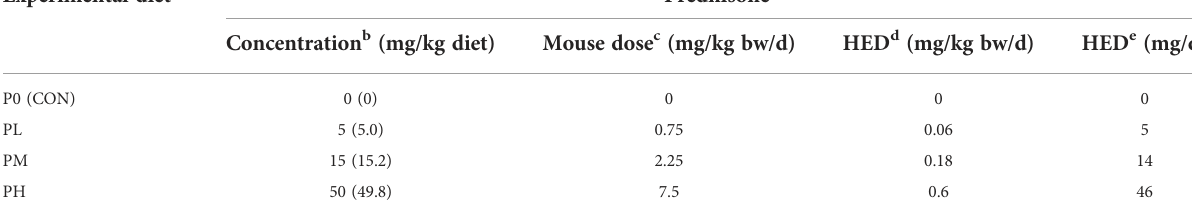
TABLE 1 Relation of prednisone concentrations in experimental diet to mouse and human daily doses. Experimental diet